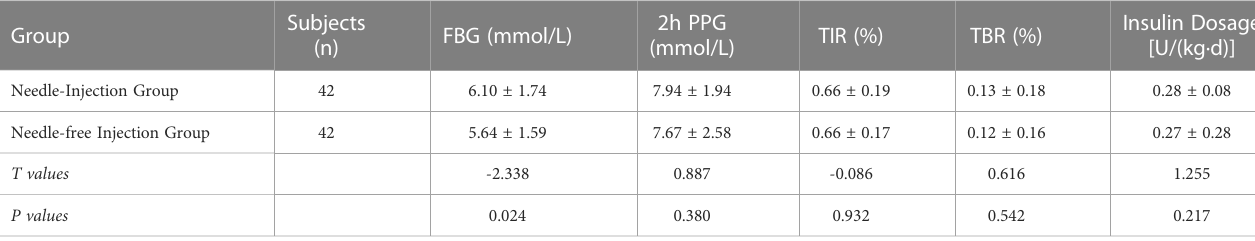
TABLE 2 Comparison of the effects of two the injection methods on blood glucose related indexes ( (cid:1) x sd ).